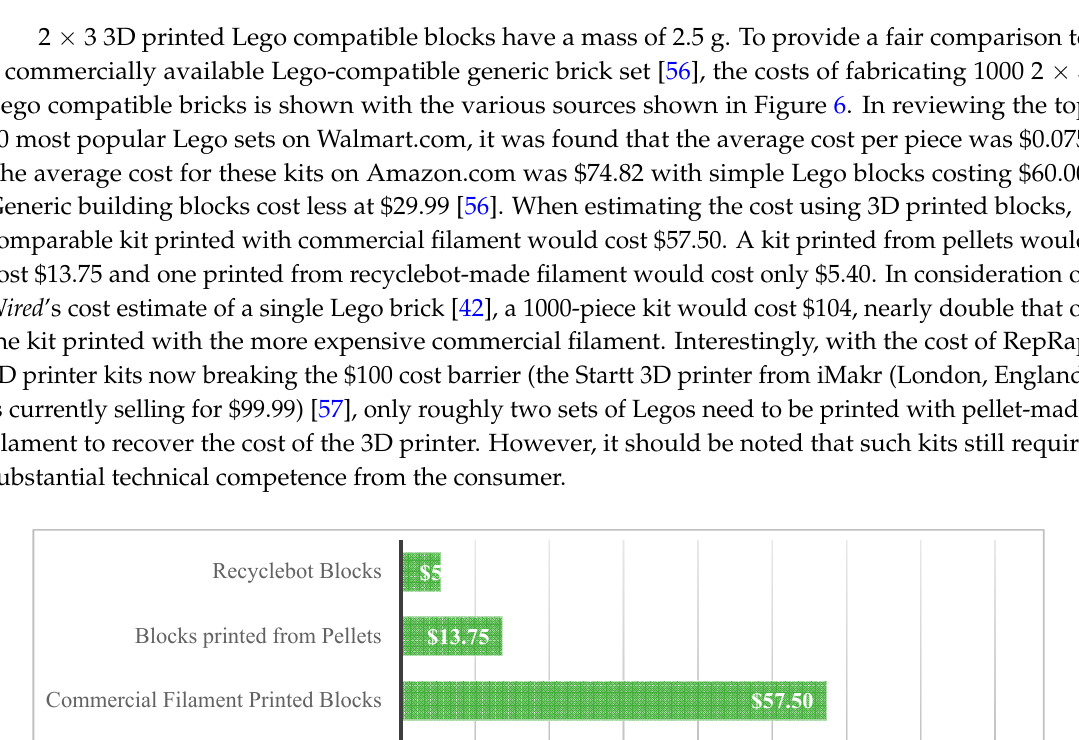
Figure 5. Adapterz LLC free design of a Lego to Lincoln Log adapter [55] shown in Cura.